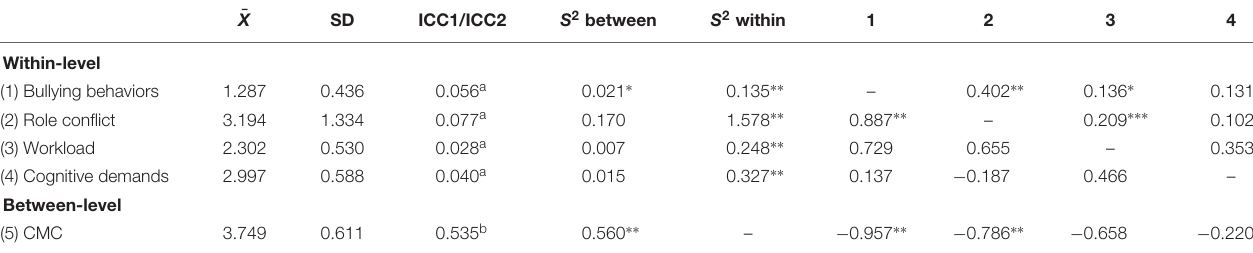
TABLE 1 | Mean, standard deviation, ICC, and within- and between-level correlations for all study variables ( N = 462 participants, N = 147 teams). ¯ X SD ICC1/ICC2 S 2 between S 2 within